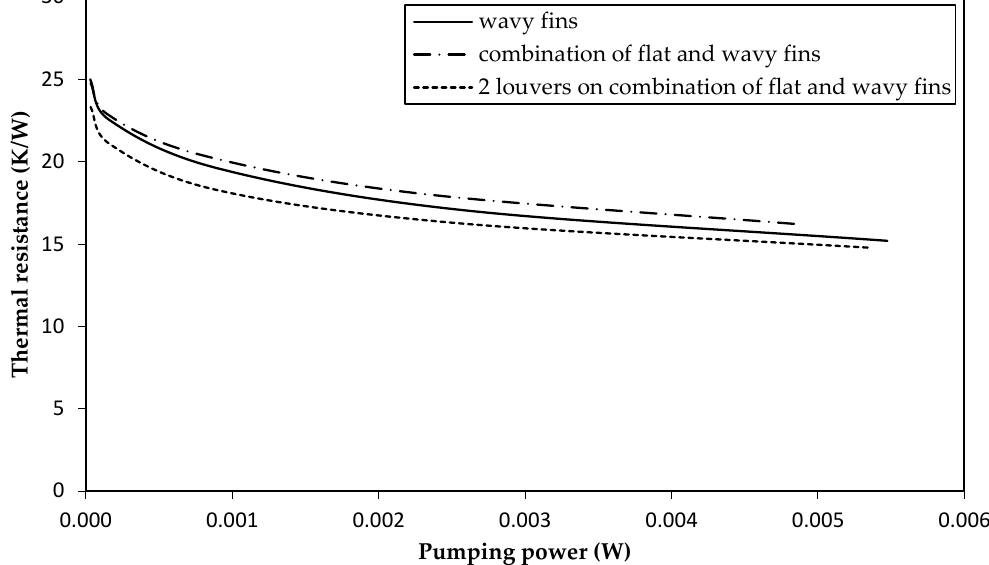
Figure 7. Thermal resistance vs. pumping power for comparison between wavy fins and combination of flat and wavy fins with and without louvers ( W = 8 mm, n = 2) .